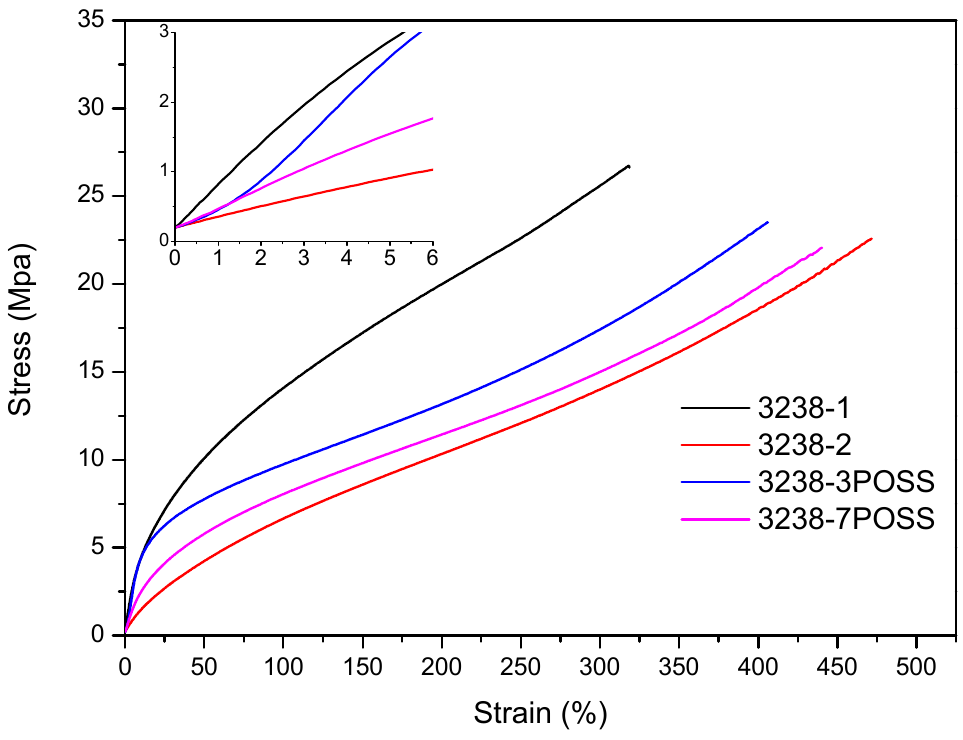
Figure 11. Stress–strain curves of WPUD films from experimental design that included POSS-OH in the ternary mixture.